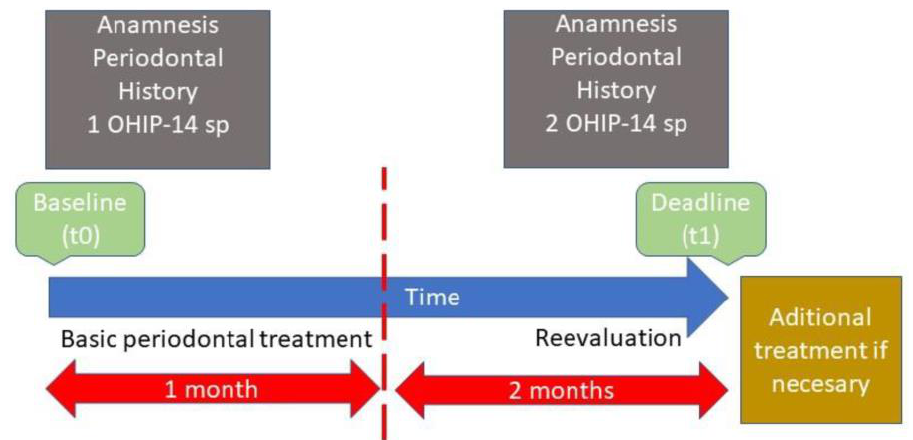
Figure 1. Study flow chart.